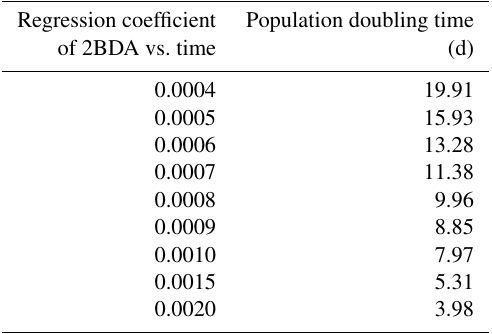
Table 3. Inferred algal population doubling time for given regres- sion coefficients of 2BDA vs.